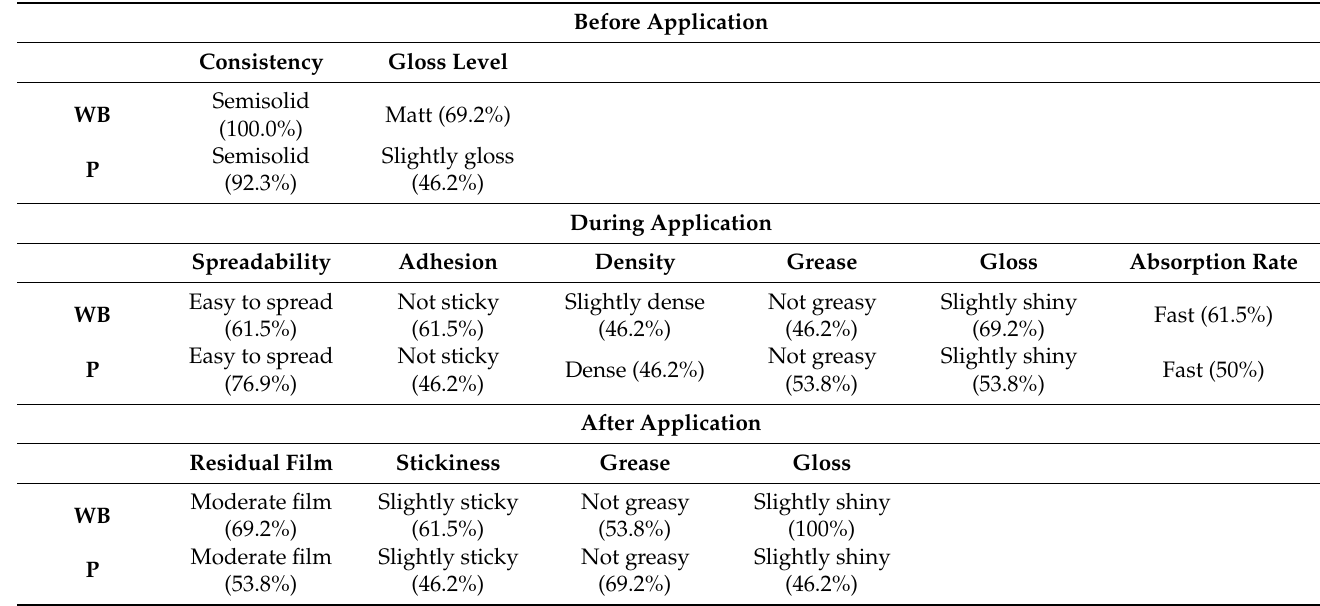
Table 6. The results of sensory analysis of the investigated samples